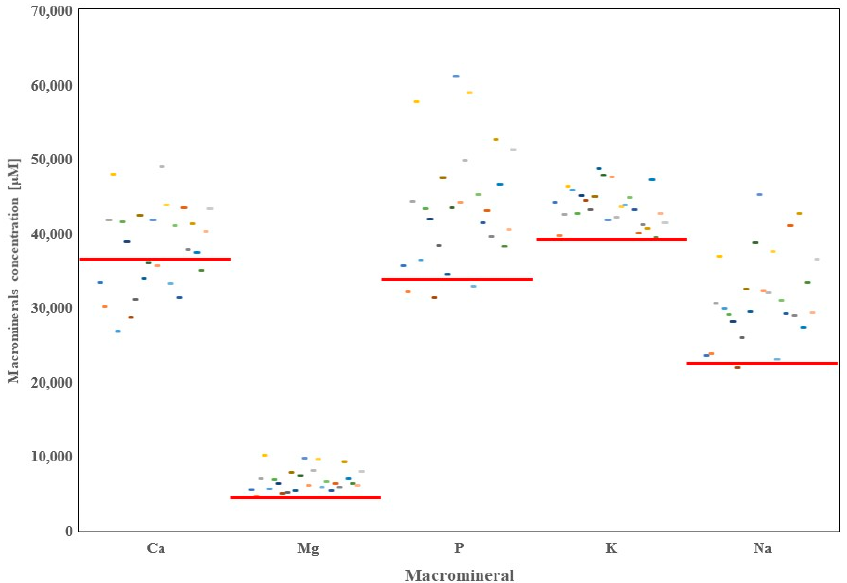
Figure 1. Distribution of macrominerals in raw milk samples from 26 dairy farms in Alberta with regards to world averages (red line).